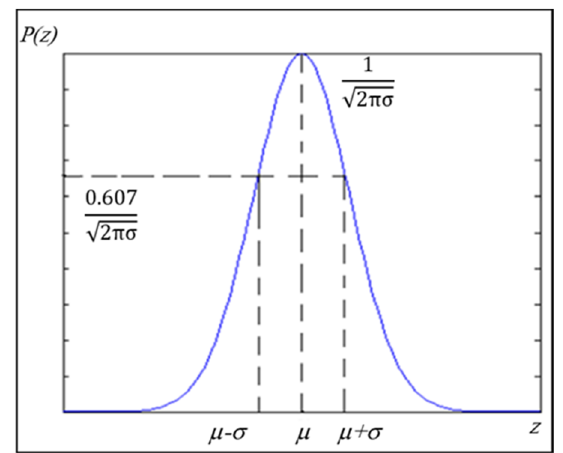
Figure 4: PDF for Gaussian noise [ 22 ] .